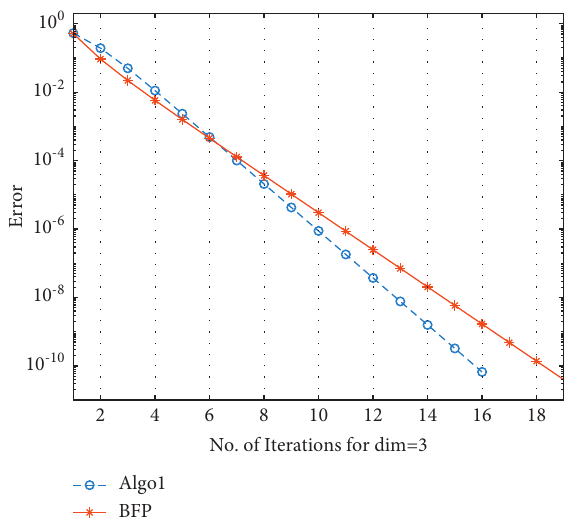
Figure 6: Iteration no. vs error for dimension 3.